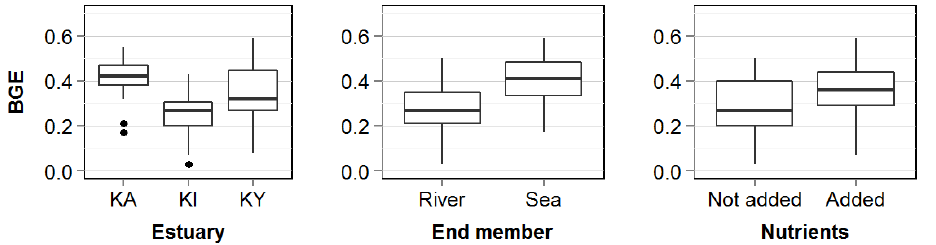
Fig. 7. Box plots showing variation in bacterial growth efficiencies between experiment units. Whiskers indicate the minimum and maximum observations, lower and upper ends of boxes indicate lower and upper quartiles, and thick horizontal line is the mean value of each data set. In the left panel data is divided by the estuaries: KA: Karjaanjoki, KI: Kiiminkijoki and KY: Kyrönjoki. In the middle panel the difference between river and sea endmembers is shown. In the right panel the effect of nutrient additions is presented. Differences between estuaries, endmembers and nutrient manipulations are significant ( P ≤